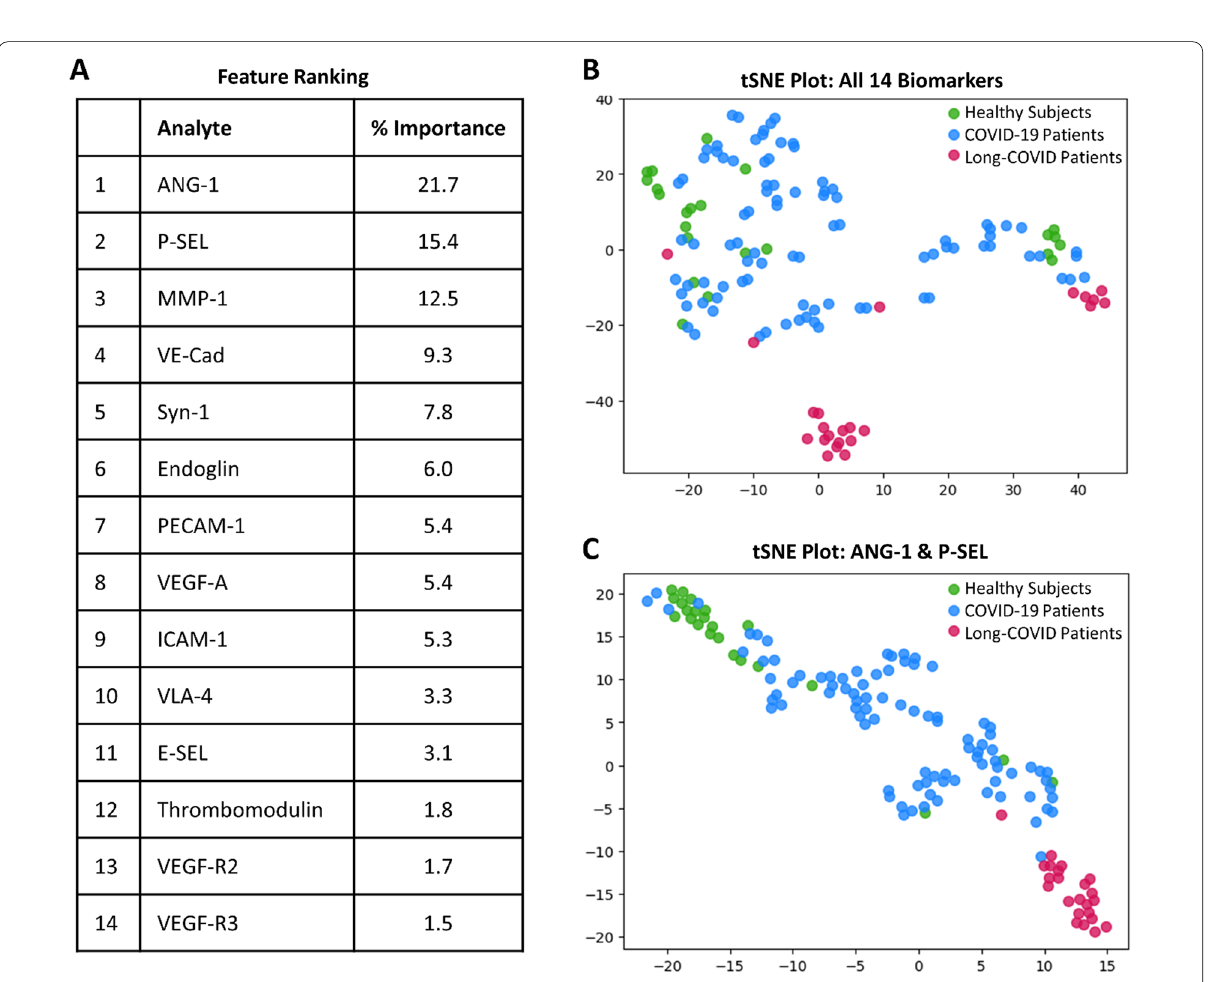
Fig. 1 Identification of important vascular transformation blood biomarkers in Long-COVID outpatients. A List generated with a Random Forest indicating the relative importance of fourteen blood biomarkers for classifying subjects between cohorts. The leading two biomarkers were ANG-1 and P-SEL. B Subjects plotted in two-dimensions, following t-SNE dimensionality reduction of all fourteen significant biomarkers, shows separation cluster of Long-COVID outpatients with some mixing with acutely ill COVID-19 inpatients and healthy control subjects. C Subjects plotted in two-dimensions, following t-SNE dimensionality reduction of two selected biomarkers, ANG-1 and P-SEL, showed distinct separation and clustering of Long-COVID outpatients from acutely ill COVID-19 inpatients and healthy control